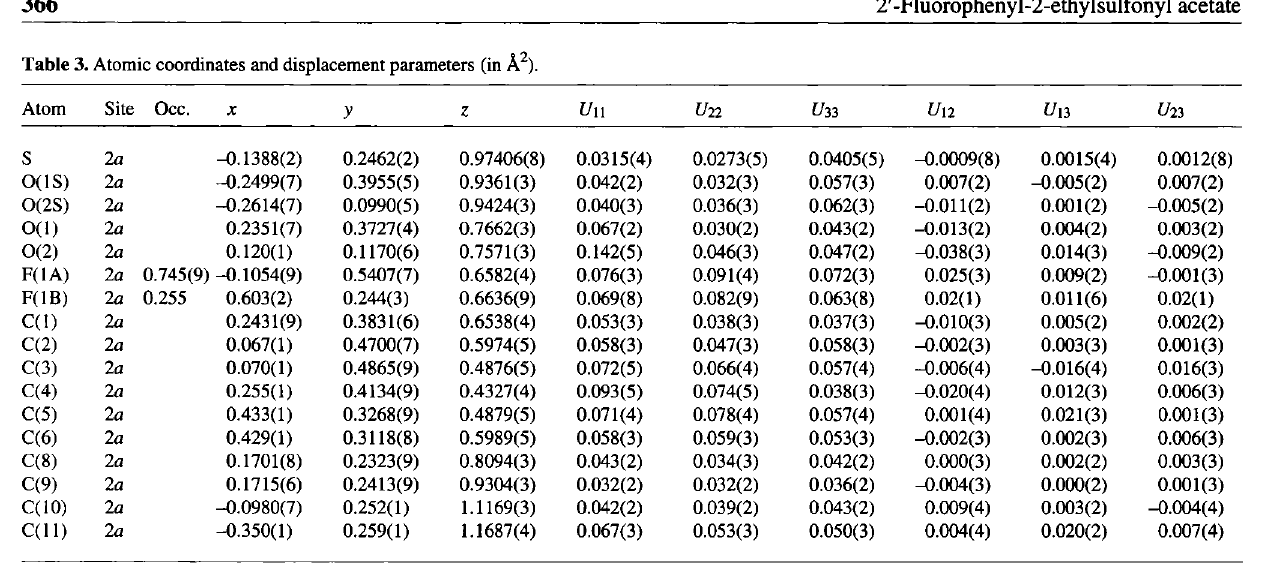
Table 3. Atomic coordinates and displacement parameters (in Â 2